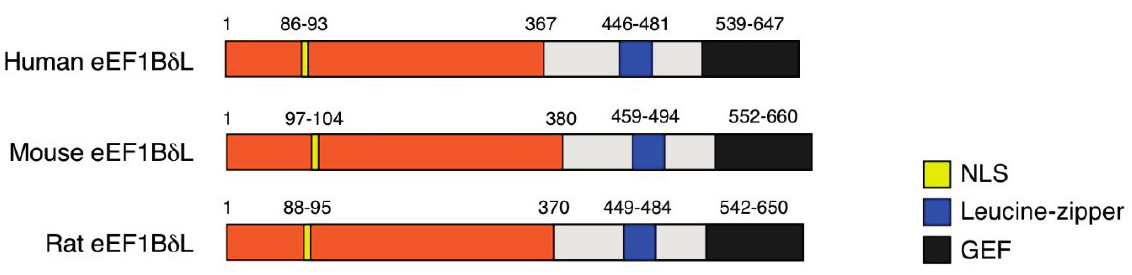
Figure 2. Comparison of eEF1B δ L structural domains between human and rodent orthologs. The nuclear localization signal (NLS), leucine-zipper motif and guanine nucleotide exchange factor (GEF) domain are well conserved between human and rodent orthologs. The numbers of amino acids are